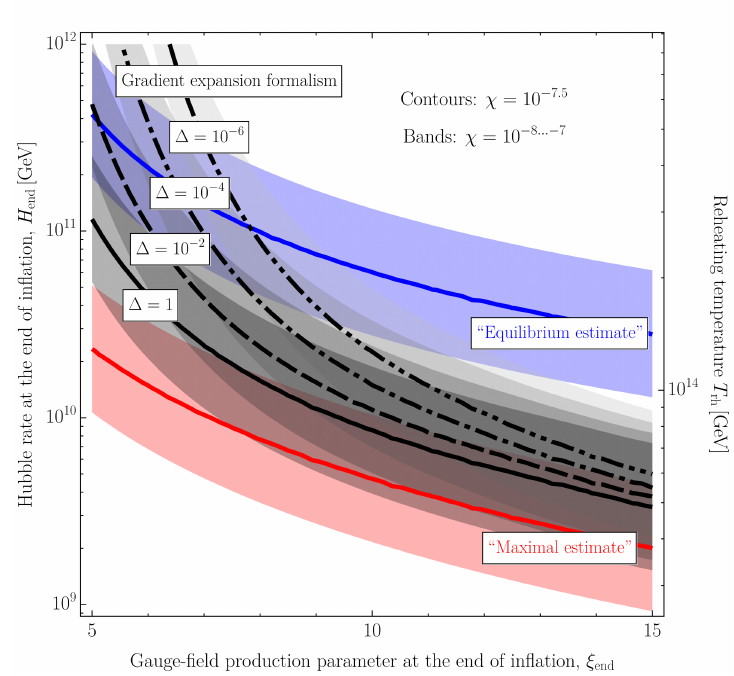
Figure 1 . Estimates of the parameter region where the yield parameter χ [see eqs. (2.25) and (2.31)] is of the right order of magnitude for successful baryogenesis (see sections 4.2 and 4.3). The contour lines indicate where in parameter space we expect χ = 10 − 7 . 5 , while the shaded bands cover the corresponding range from χ = 10 − 8 to χ = 10 − 7 . Here, larger values of H end correspond to larger values of χ , according to the scaling law χ ∝ H 3 / 2 for fixed ξ [see eqs. (2.23) and (2.31)]. We end compare the equilibrium estimate (blue) and maximal estimate (red) in the magnetic picture [36] to the GEF estimate (black) in the electric picture [38] for different values of the damping factor ∆ [see eq. (2.36)]. The reheating temperature T rh follows from the Hubble rate H end according to eq.